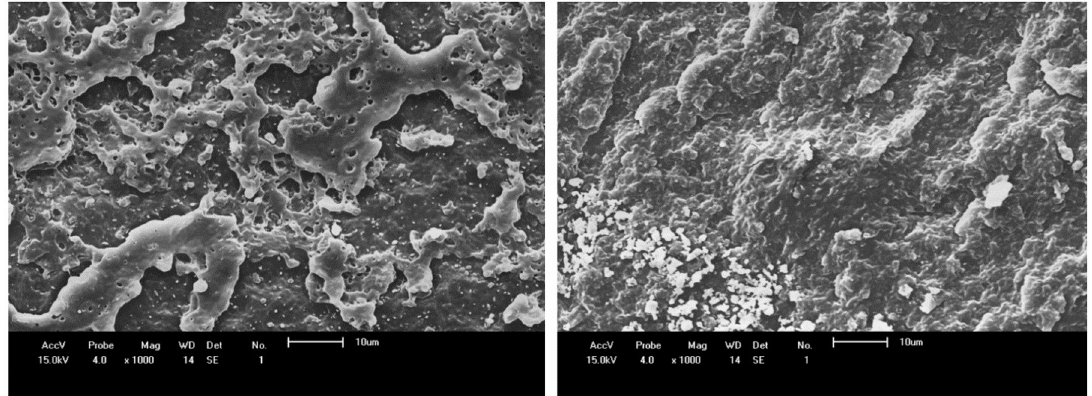
Figure 9. SEM images of fractured surfaces of PHB/1%AO before (left) and after (right) thermal aging at 115ºC for 120 hours. Magnification of 1000x